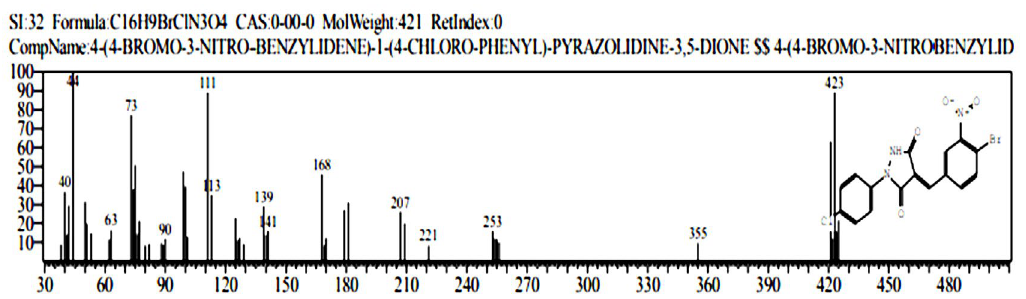
Fig. 9. Chemical compounds ( 4 - Bromo - 3 -Nitro - Benzylidene) -1- (4- Chloro - Phenyl)